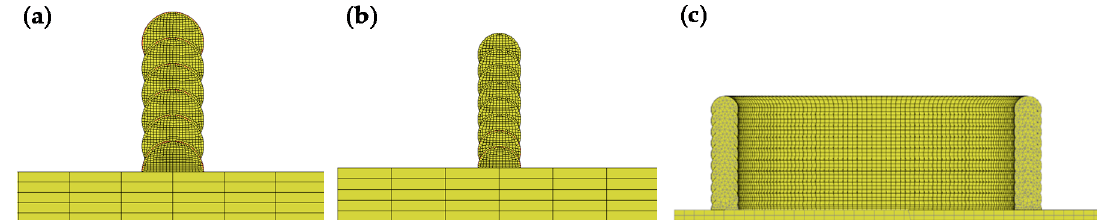
Figure 4. Finite Element (FE) models with the mesh: ( a ) wall with wire feed of 5 m/min; ( b ) wall with wire feed 2.5 m/min; ( c ) tube with wire feed 5 m/min.